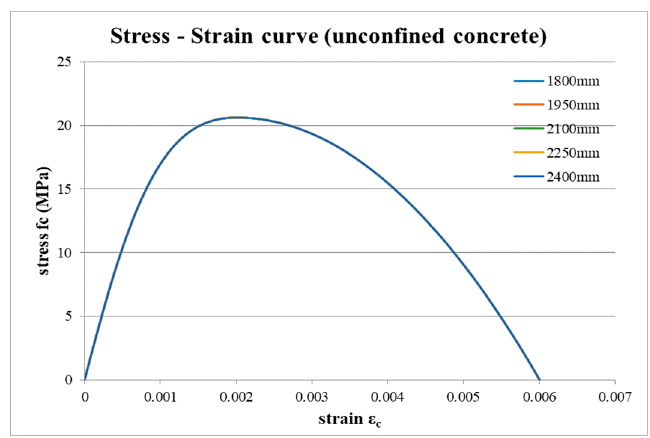
Figure 6. Stress–strain curve for unconfined concrete.